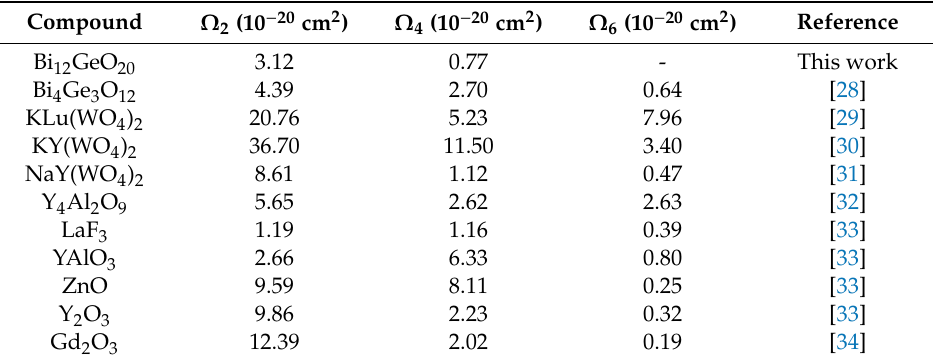
Table 3. The comparison of Judd-Ofelt parameters in di ff erent Europium doped